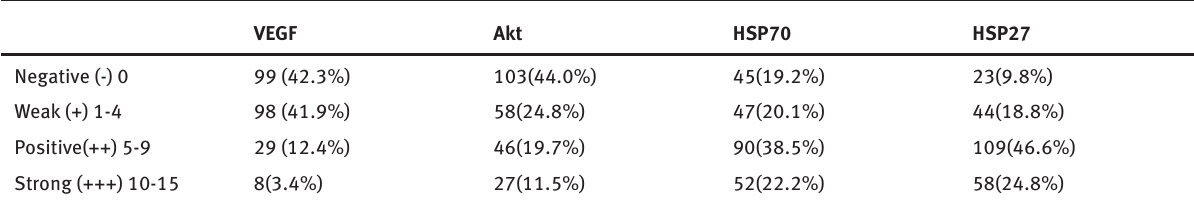
Table 1: The results of immunohistochemical stain for VEGF, Akt, HSP70 and HSP27 in HCC patients